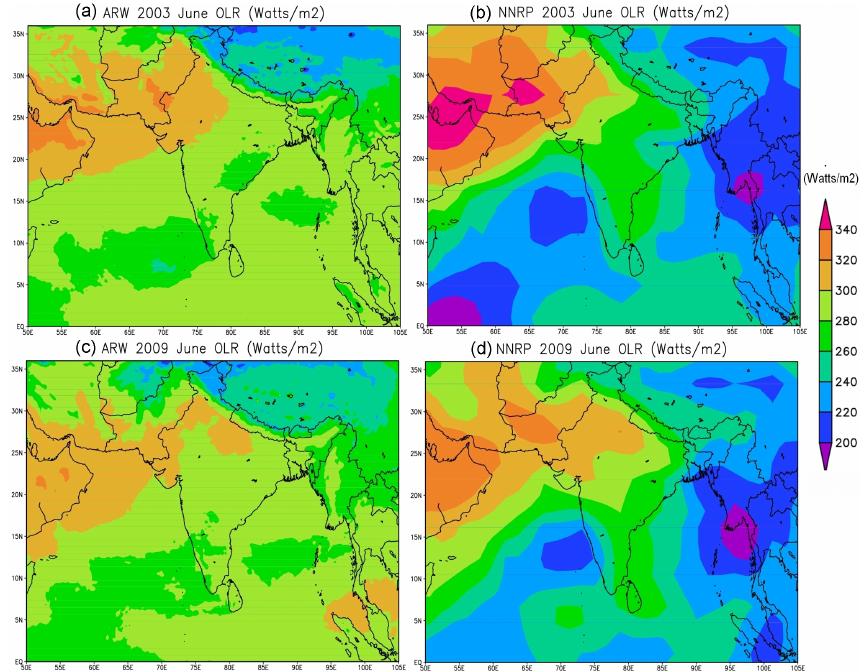
Figure 12. Outgoing long-wave radiation (OLR) in wattsm − 2 from simulation and NNRP data for the years 2003 (a, b) and 2009 (c, d) . The left panels (a, c) represent ARW simulation and the right panels (b, d) NNRP reanalysis.